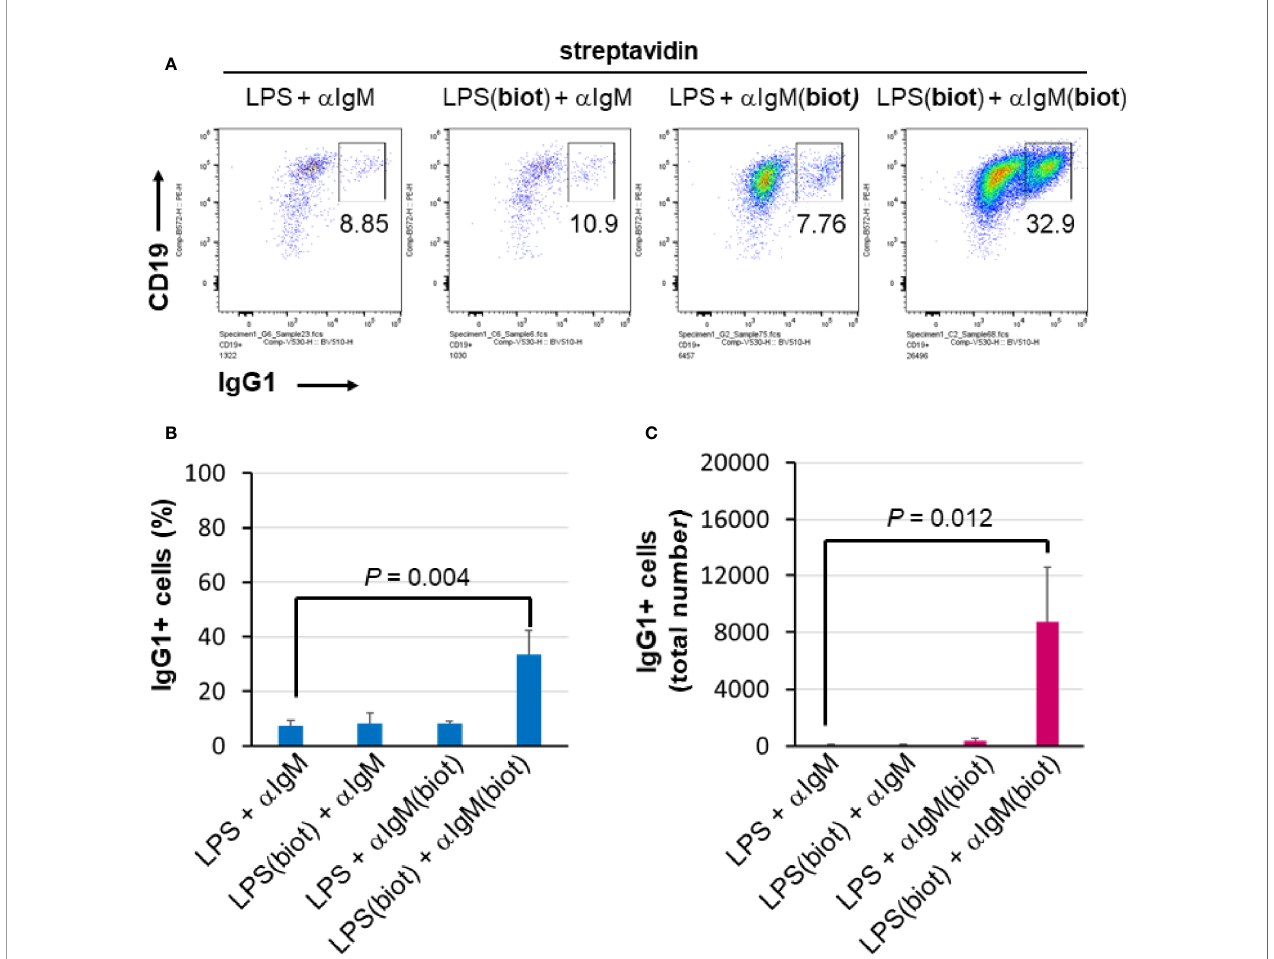
FIGURE 4 | Multimericities of BCR engaging anti-IgM and TLR4-engaging LPS are critical for enhanced B cell proliferation and CSR. (A) To distinguish whether multimerization of LPS or anti-IgM is responsible for the enhanced effect at inducing B cell proliferation and CSR, unbiotinylated or biotinylated LPS (0.3 m g/ml = 0.075 m g/ml per well), and anti-IgM F(ab ’ ) 2 (0.1 m g/ml = 0.025 m g/ml per well) were conjugated to streptavidin (1 m g/ml = 0.25 m g/ml per well) in some wells of a 96- well V-bottom polypropylene plate. These streptavidin:biotin immunoconjugates were then added to splenocyte cultures (2.5 x 10 5 cells/ml in each well) in 96 well fl at bottom tissue culture plates in RPMI-FBS/BME, also in the presence of 50 ng/ml IL-4, for 4 days. Flow cytometry of representative results indicates that biotinylation of both LPS and anti-IgM is required for maximal CSR to IgG1 in this system. (B) Quanti fi cation of cell proliferation in the four conditions described above. (C) Quanti fi cation of CSR to IgG1 in the four conditions described above. It is notable that maximal proliferation and CSR occurs only when both LPS and IgM are biotinylated and premixed to